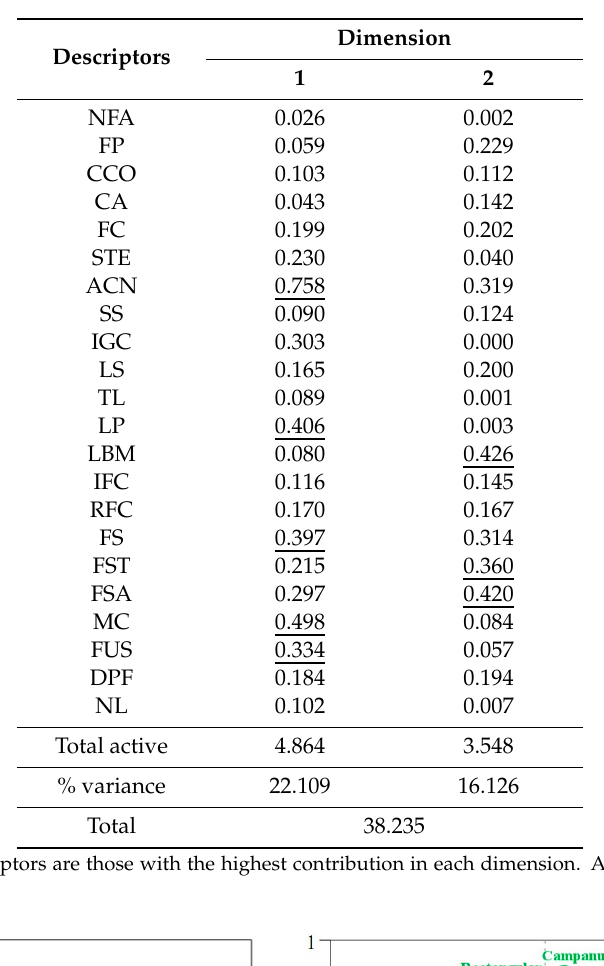
Table 3. Results of the multiple correspondence analysis (MCA) carried out from the qualitative and quantitative traits of the assessed F1 lines and progenitors of habanero pepper.